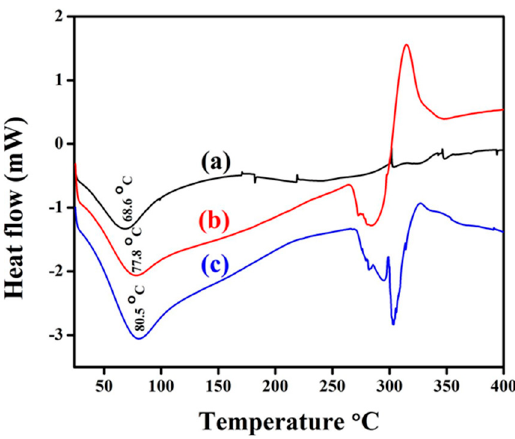
Figure 5. DSC curves of the GNF ( a ) and the 5% GNF-based nanocomposites, incorporated with PS ( b ) and TS ( c ).